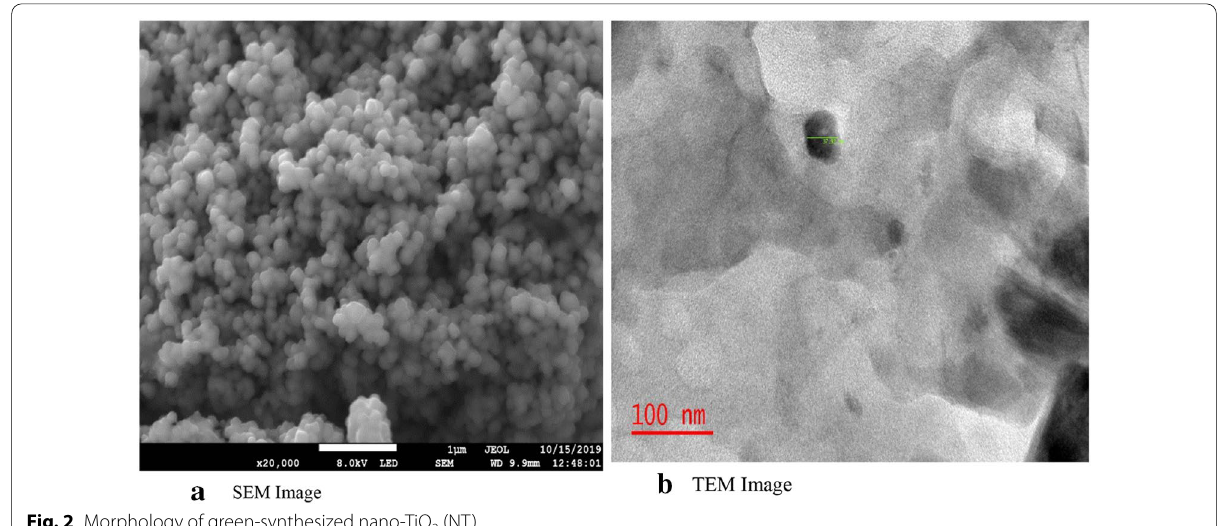
Fig. 2 Morphology of green-synthesized nano-TiO 2 (NT).